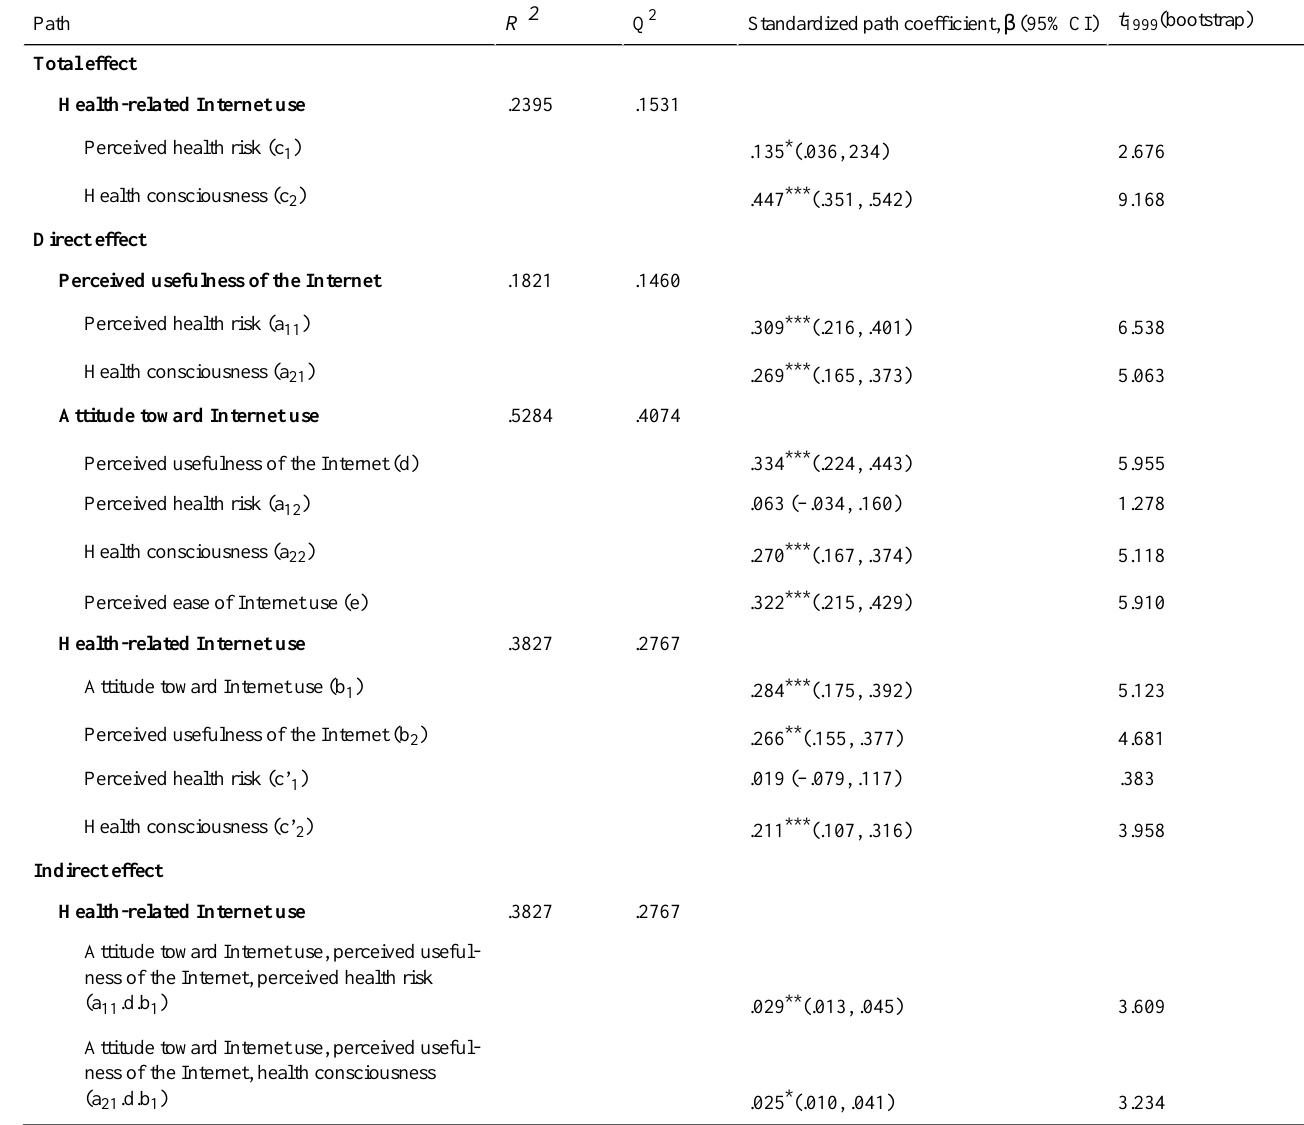
Table 5. Direct, indirect, and total effects.